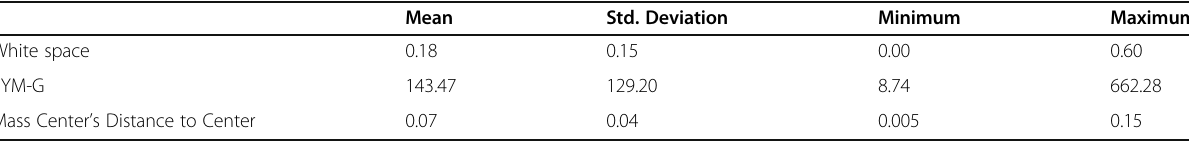
Table 2 Statistics of three main